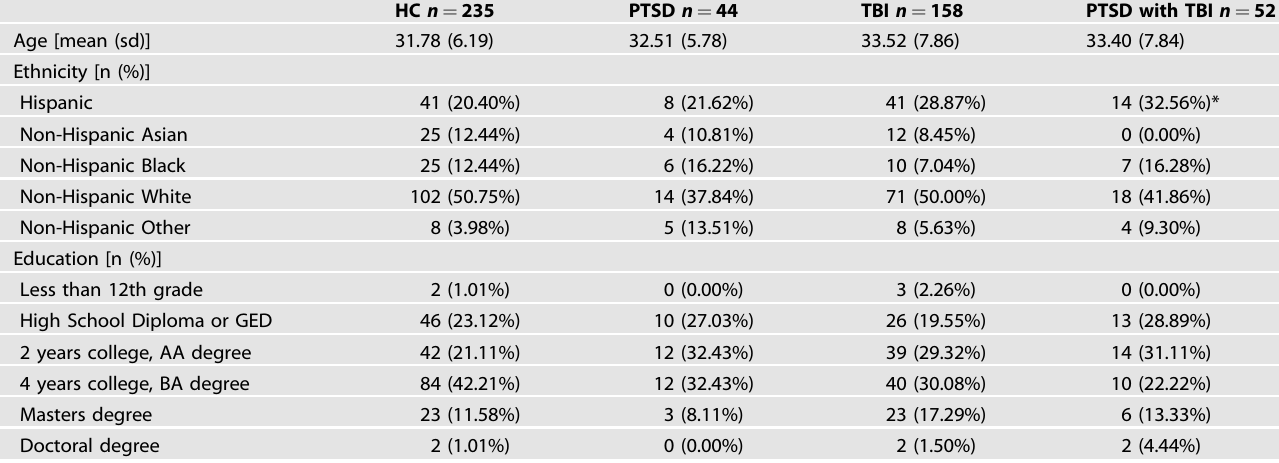
Table 2. Demographics of veterans who completed CLIA blood